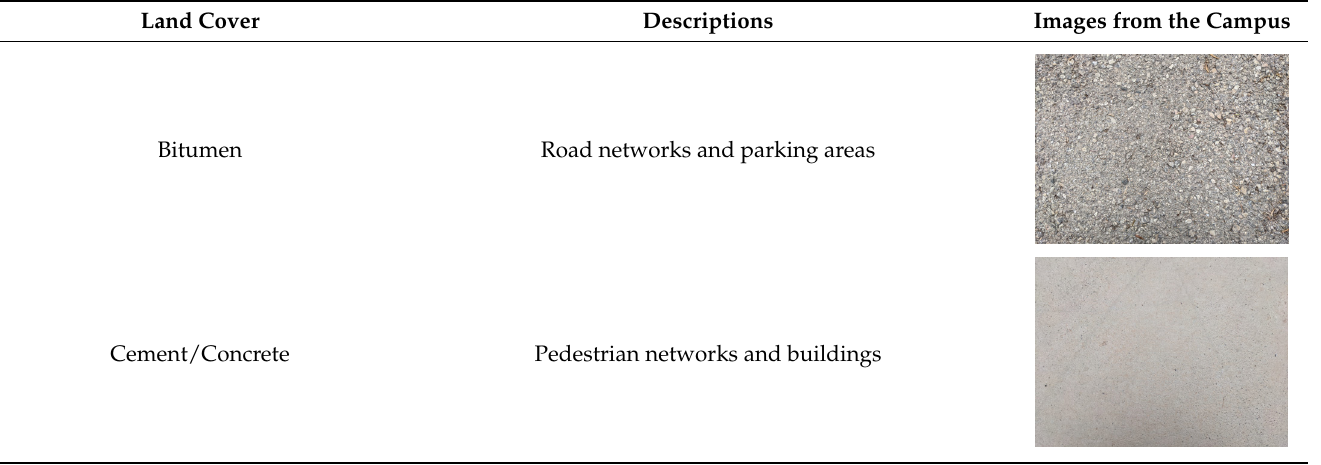
Table 1. Descriptions of the urban land-cover classes in the study.